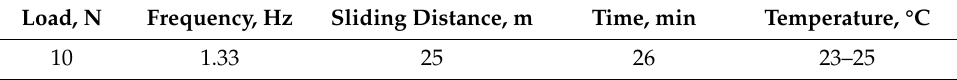
Table 3. Tribological test